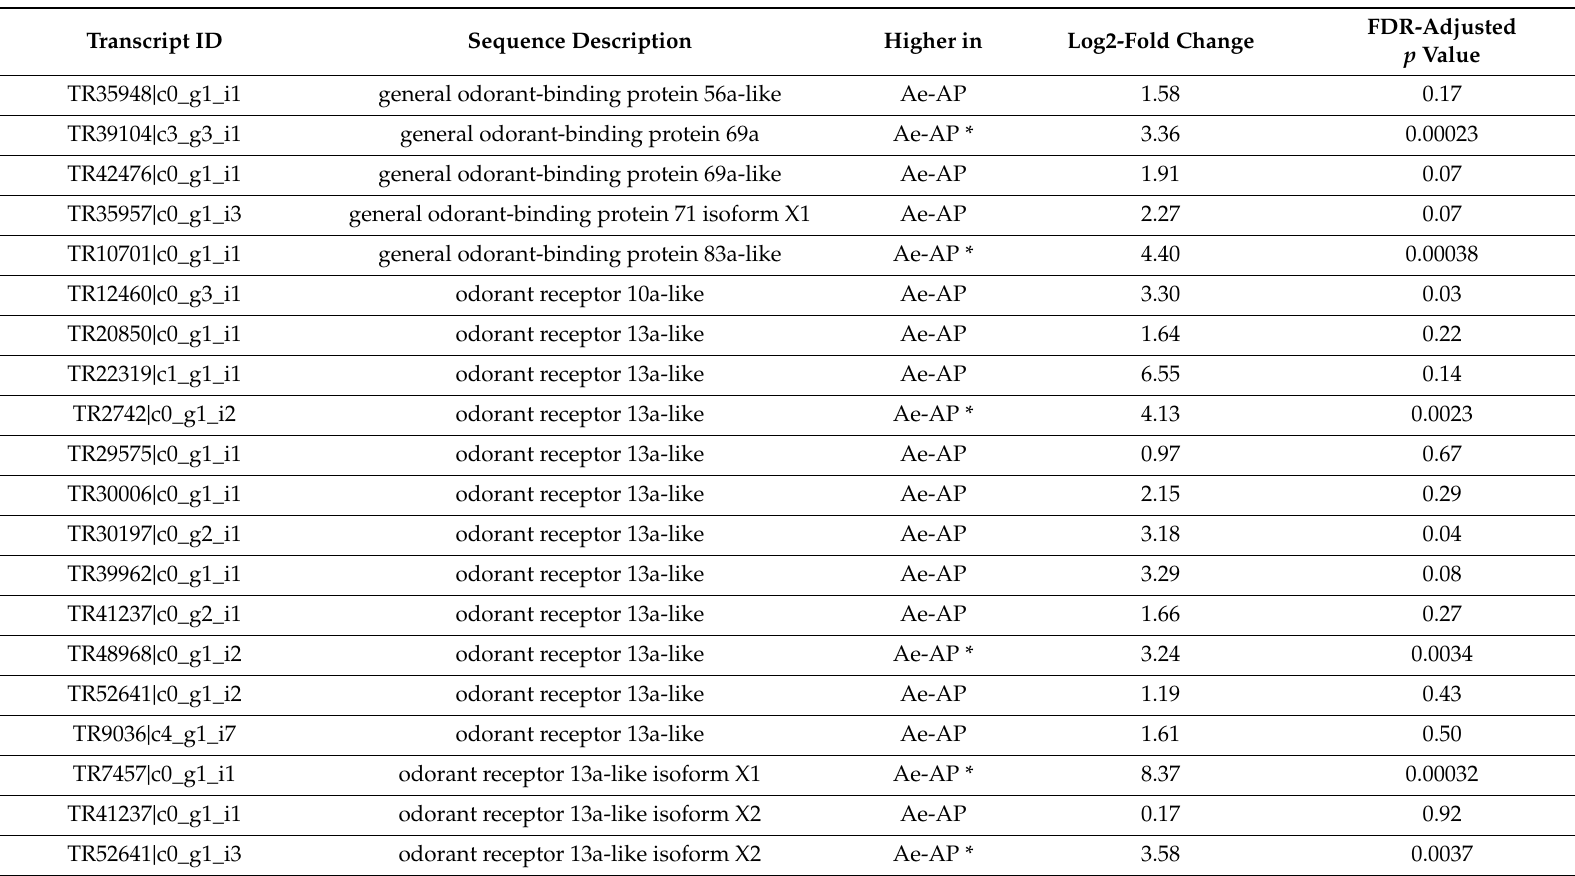
Table 1. Chemosensory genes annotated from the Aphidius ervi reference transcriptome assembly. Transcripts displaying significant di ff erential expression patterns between A. ervi–Acyrthosiphon pisum (AP) and A. ervi–Sitobion avenae (SA) are marked in bold characters and with *. FDR: false discovery